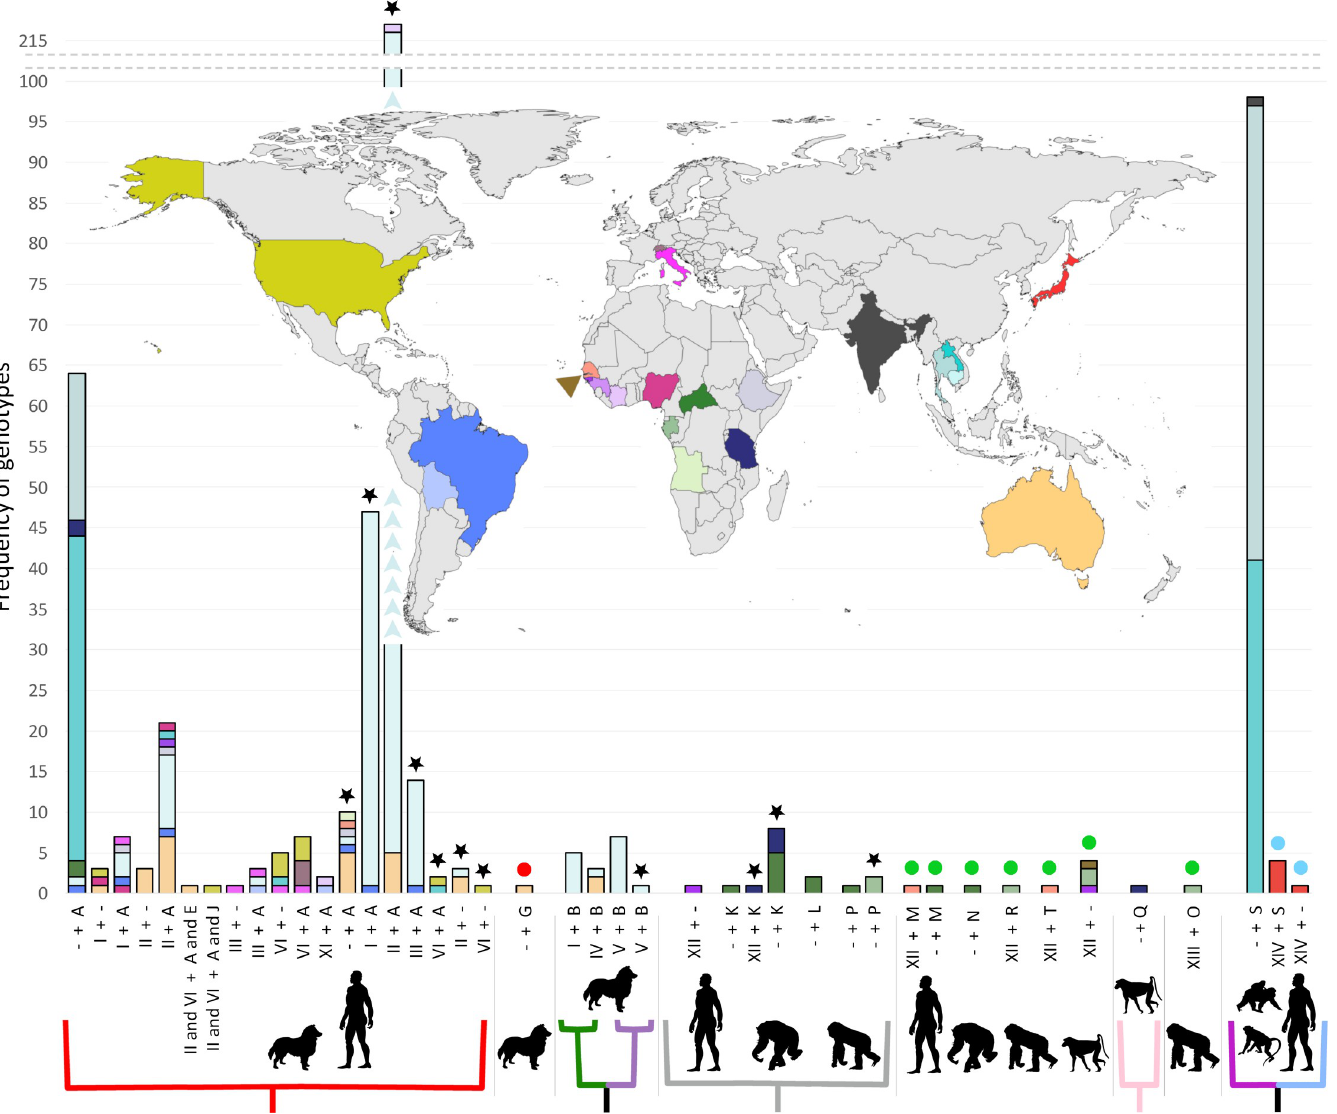
Fig 3. Global frequency of Strongyloides spp. 18S genotypes. Histogram bars are colored according to their origin, corresponding to the colors on the map. A dash in the horizontal axis labels (-) indicatesa missing 18S haplotype (either HVR-I or HVR-IV). The colored branches below the horizontal axis correspond to the colored branches in Fig 2,where the red clade representsS. stercoralis types infecting both dogs and humans (lineage A), the green/purple clade representsS. stercoralis types infecting only dogs (lineage B), the gray clade representsS. fuelleborni types from African great apes and humans, the light pink clade representsS. fuelleborni from a baboon and the magenta/ light blue clade representstypes found in humans and macaques. The absence of a coloredbranch under a given group indicates that an associated cox1 sequence is presently unavailable for these 18S haplotypes. Black star: A cox1 sequence is not available for these specific worms yet they were assigned to their most appropriate cox1 clades based on the observation that their 18S types have only ever been found previously in worms with cox1 sequences belonging to these clades. Red circle: A novel 18S HVR-IV type without a corresponding cox1 sequence available. As this 18S type had not been described previously, its association with any particular cox1 clade is unknown and cannot be inferred. Green circles: Strongyloidesfuelleborni 18S types without corresponding cox1 sequencesavailable. As cox1 sequence data has not been provided for worms with these 18S types, their associationwith any particular cox1 clade is unknown.Blue circles: Strongyloidesfuelleborni 18S types from Japanese macaques. Corresponding cox1 sequences are not available for these specific worms, yet they were assigned to the magenta/light blue clades because all known cox1 sequences from S. fuelleborniinfecting Japanese macaques have belonged to this group. This figure incorporates the corrections detailed in Table 4.